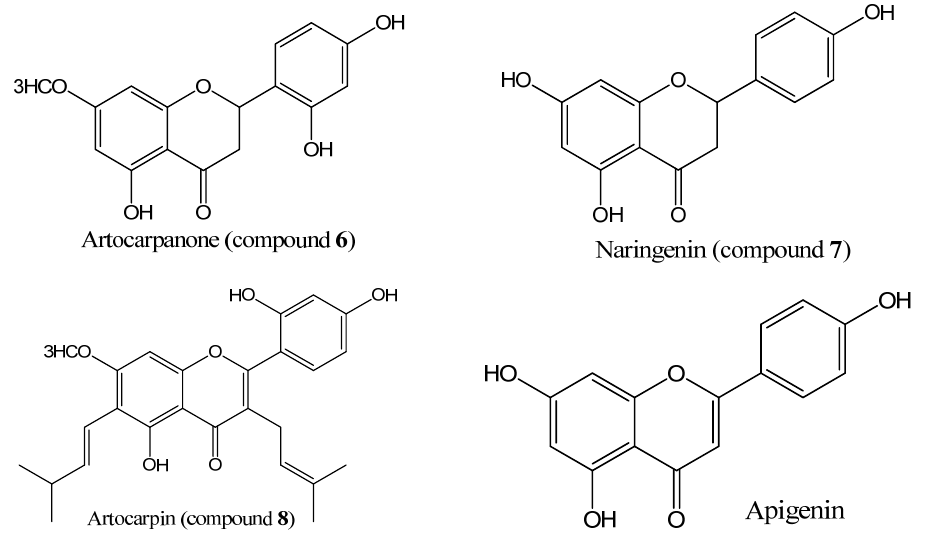
Figure 1. The isolated compounds and apigenin.